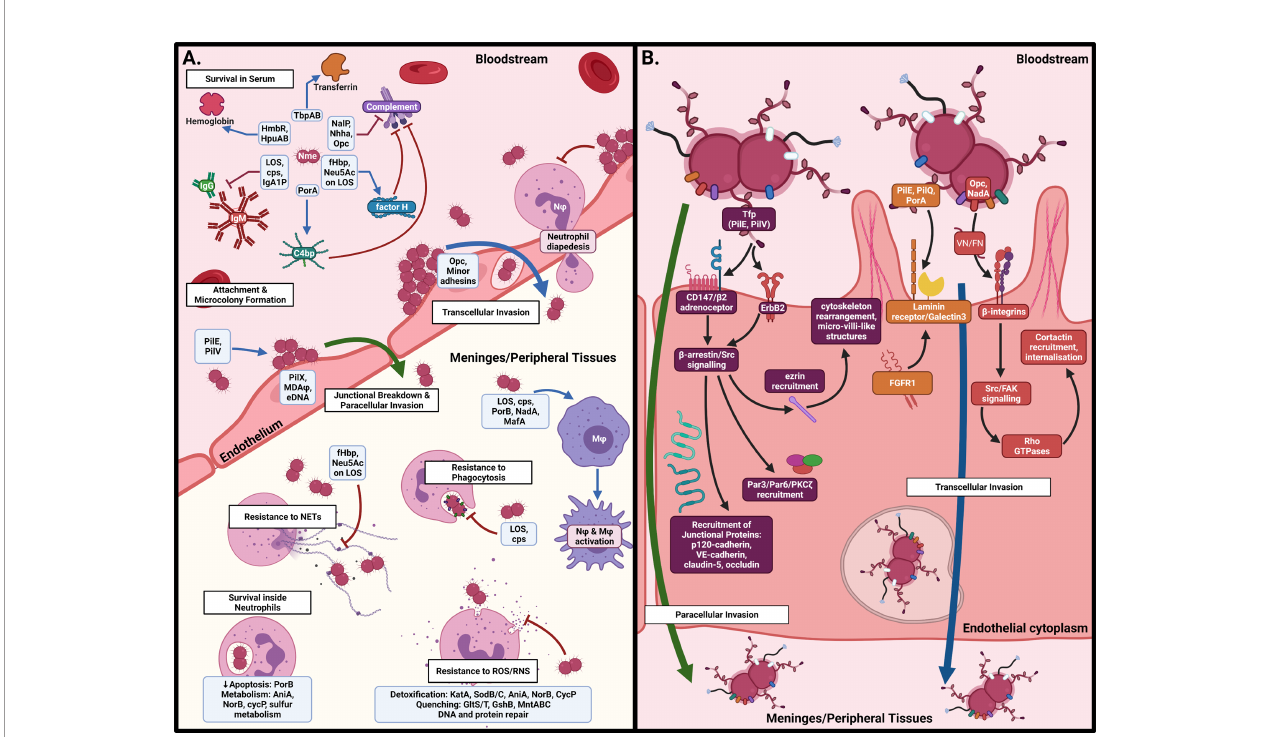
FIGURE 3 | Interactions of N. meningitidis in the systemic circulation. (A) In the bloodstream, Nme must resist antibody- and complement-mediated killing, acquire iron, and attach to the capillary endothelial surface to form microcolonies. Once attached, Nme possesses several mechanisms to resist the actions of phagocytic cells, including neutrophils and macrophages. (B) Binding of endothelial cells occurs by interaction of meningococcal surface structures with their cognate receptors, resulting in cortical plaque formation, transcytosis, and breakdown of tight junctions. This fi gure was created using